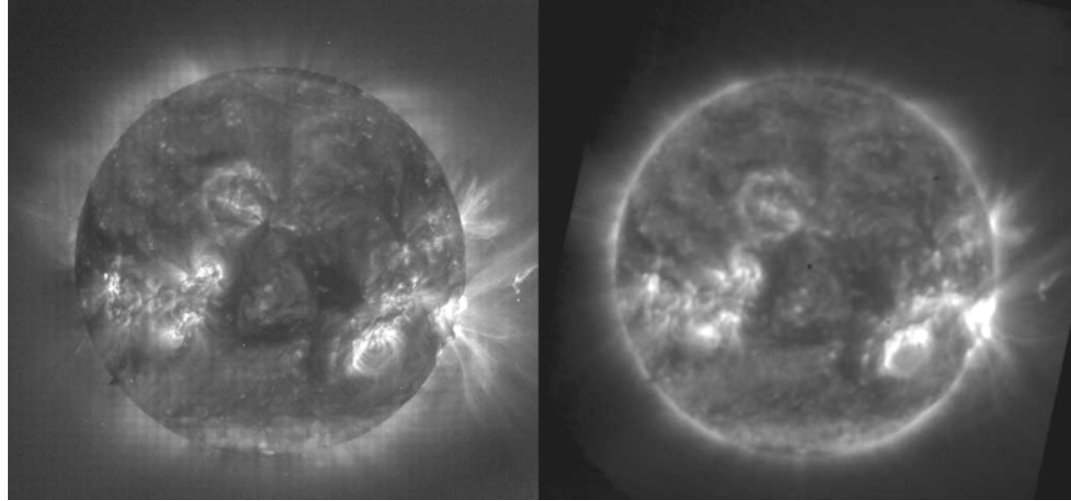
Fig. 3. On the left, a SOHO/EIT image (19.5nm), showing an eruption above the west limb. On the right, a simultaneous CORONAS- F/SPIRIT image (17.5nm). Besides the obvious difference in spatial resolution, the two images show the same features, including the eruption (Slemzin et al.,